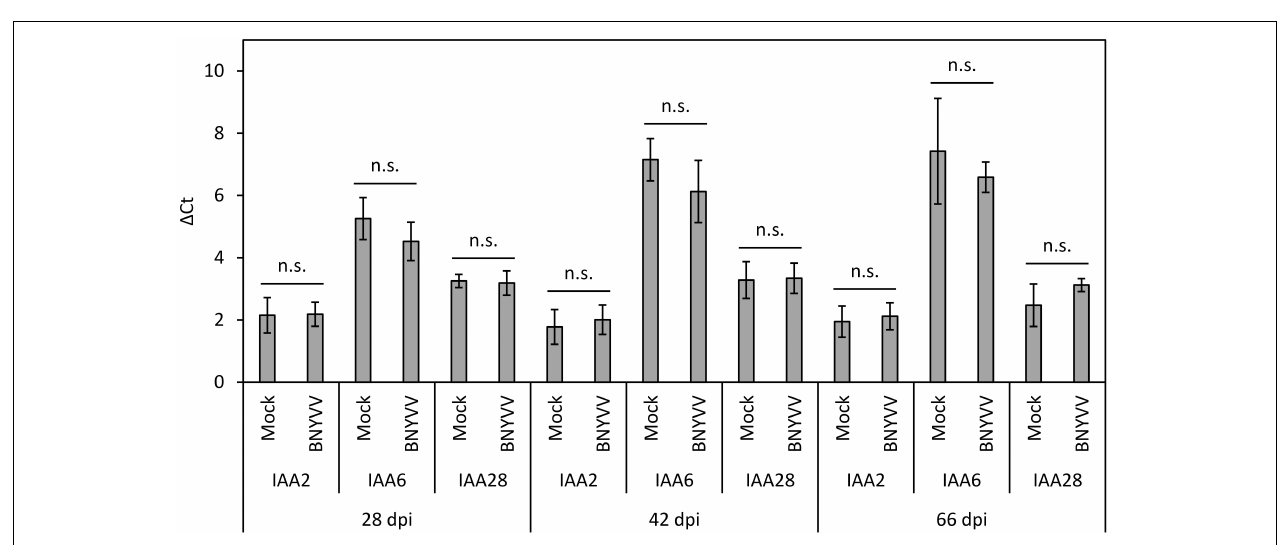
FIGURE 5 | Determination of the IAA content in BNYVV infected sugar beet roots at 42 and 66 dpi by LC-MS/MS. (A) Root phenotype of BNYVV mechanically infected vs. non-inoculated (mock) sugar beets after both harvest dates. Scale bar, 5 cm. (B) IAA content in the lateral roots and root cortex of BNYVV infected and non-inoculated sugar beet plants. Horizontal bars indicate significance (n.s. = not significant = p > 0.05; ** = 0.001 = p < 0.01) and vertical bars indicate standard deviation ( n = 8).